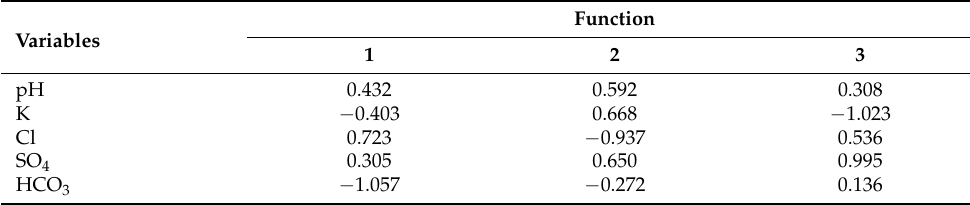
Table 10. Standardized canonical discriminant function